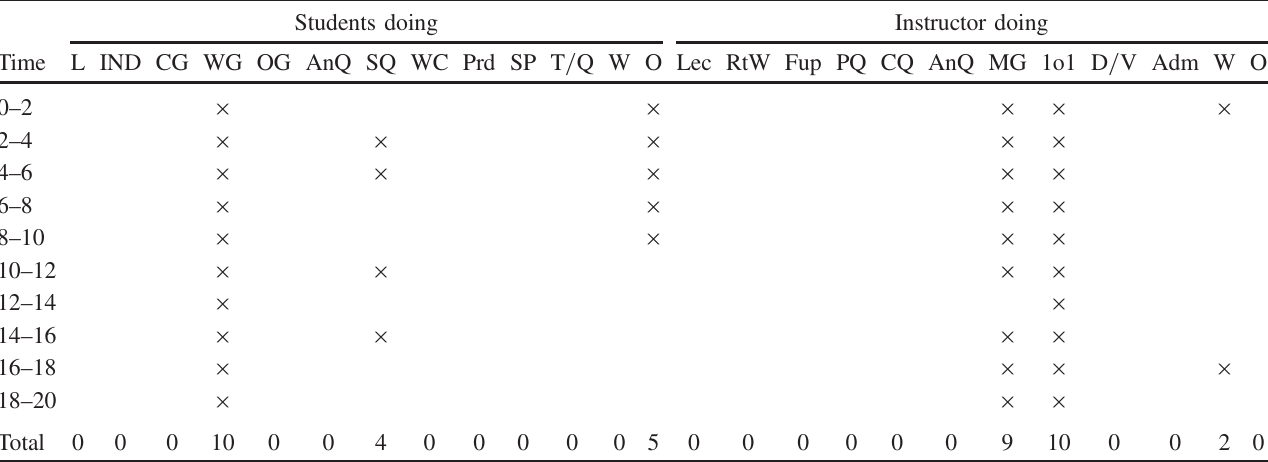
TABLE I. COPUS observation example. Time is measured in two-minute